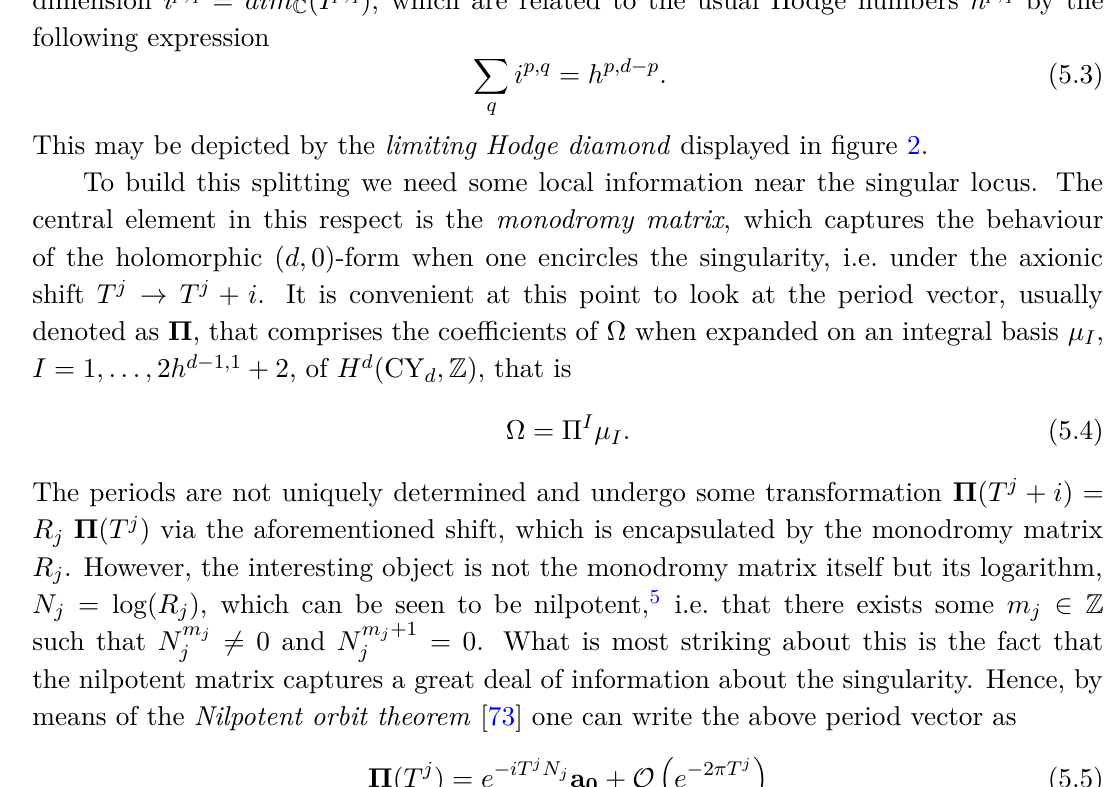
dimension i p,q = dim ( I p,q ) , which are related to the usual Hodge numbers h p,q by C